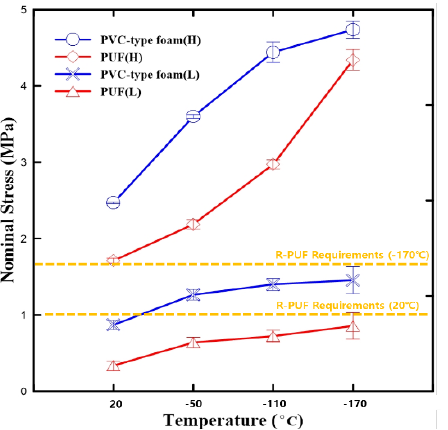
Figure 11. Nominal stress vs. temperature diagram comparing the compressive strengths of PVC-type foam and the PUF specimens with respect to R-PUF requirements at low and high temperatures.